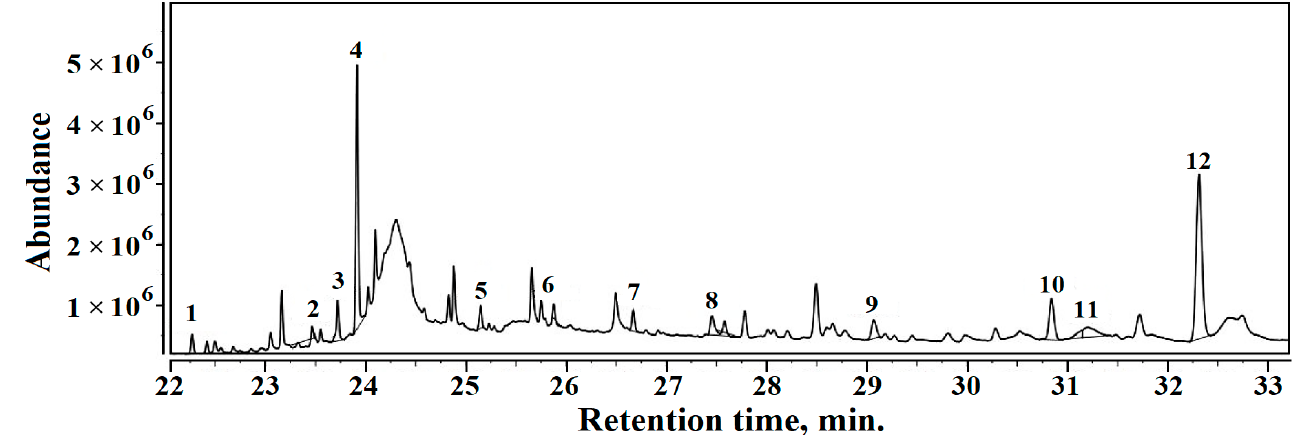
Figure 11. TIC chromatogram resulted for organic fraction within Sample 3.